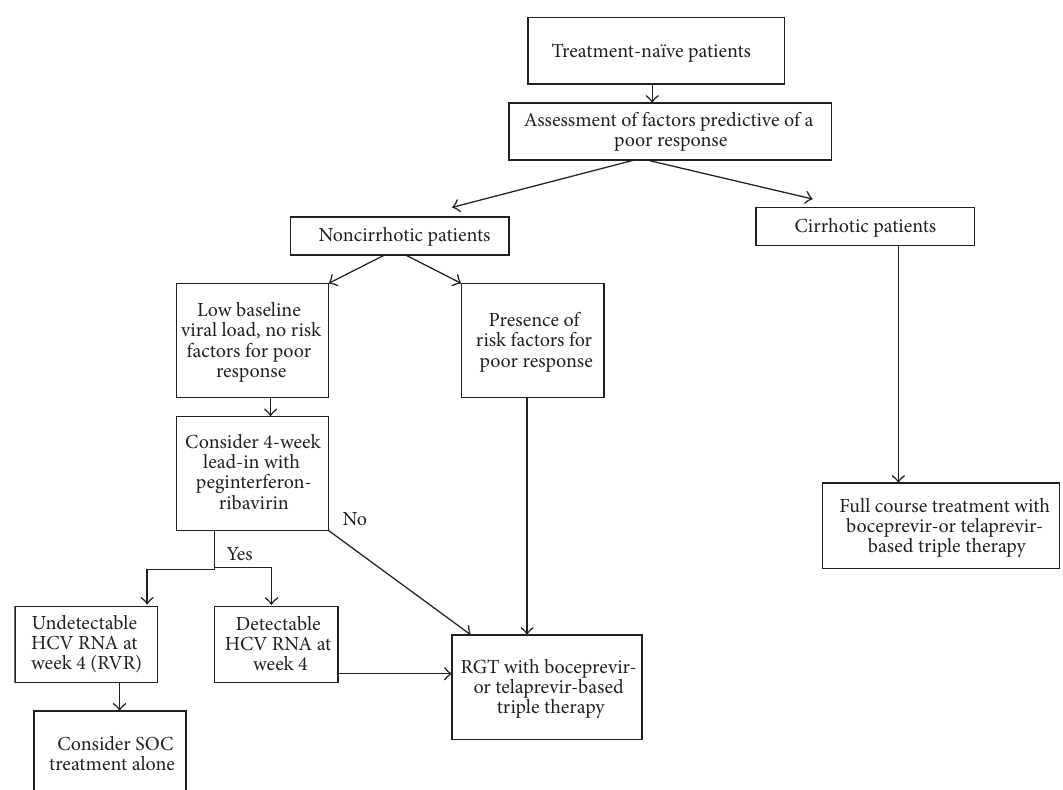
Figure3:Proposedalgorithmfortheuseofproteaseinhibitorsintreatment-na¨ıveHCVgenotype1infectedpatients.Pretreatmentassessment should include careful consideration of lifestyle factors, comorbid conditions, potential drug interactions, and assessment for the presence of cirrhosis. In noncirrhotic patients, the presence of factors predictive of a poor response to therapy should be patients with no risk factors for a poor response to therapy; the decision to use a 4-week lead-in with peginterferon and ribavirin and to continue on SOC in those who achieve an RVR should only be taken following careful and balanced discussion with the patient. Excerpted from Ramachandrean et al. [35].